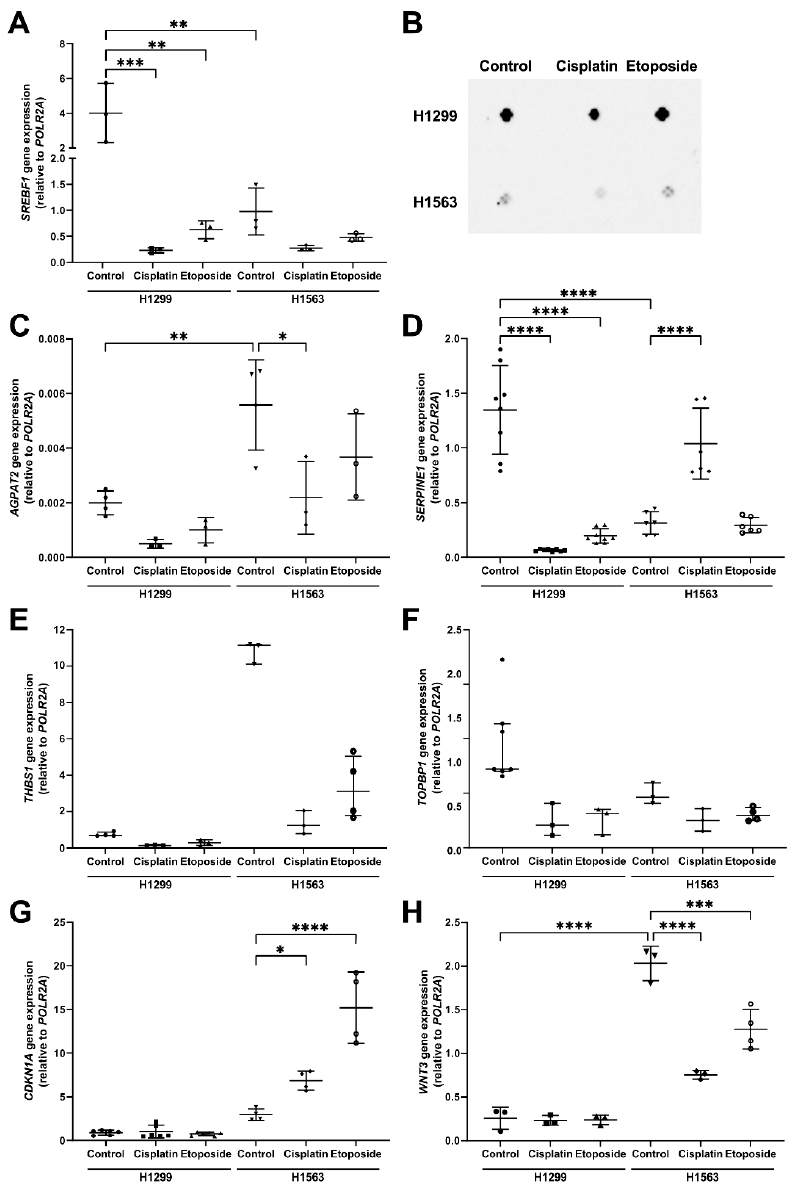
Figure 7. Transcript and protein levels of SREBF1, and expression of other genes related to lipid metabolism, apoptosis, DNA-repair, and oncogenesis processes. Cells were incubated for 48 h in the presence or absence of 100 µM etoposide or 20 µg/mL cisplatin in serum-free basal medium (BM). RNA was isolated and analyzed by real-time qPCR or cells were lysed, and protein levels were assayed. ( A ) SREBF1 gene expression; ( B ) SREBF1 protein levels analyzed by dot blots (22 µg pro- tein per dot); ( C ) AGPAT2 ; ( D ) SERPINE1 ; ( E ) THBS1 ; ( F ) TOPBP1 ; ( G ) CDKN1A ; and ( H ) WNT3 gene expression. Gene expression was carried out in duplicate from three to eight independent ex- periments. The mean (SD) was calculated with a one-way ANOVA for SREBF1 , AGPAT2, SER- PINE1, and CDKN1A genes , whereas THBS1, WNT3 , and TOPBP1 were analyzed with a Kruskal– Wallis test and presented as median (IQR). A p -value below 0.05 was considered as significant: * p < 0.05, ** p < 0.01, *** p < 0.001, and **** p < 0.0001.